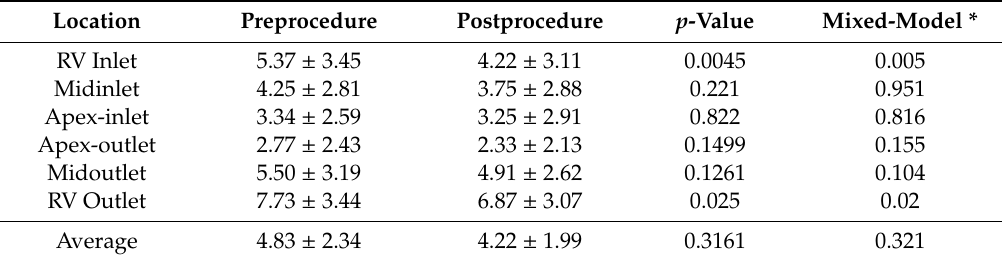
Table5. ChangeoflongitudinaldisplacementineachRVsegmentonVVI(mm)afterASDdeviceclosure.